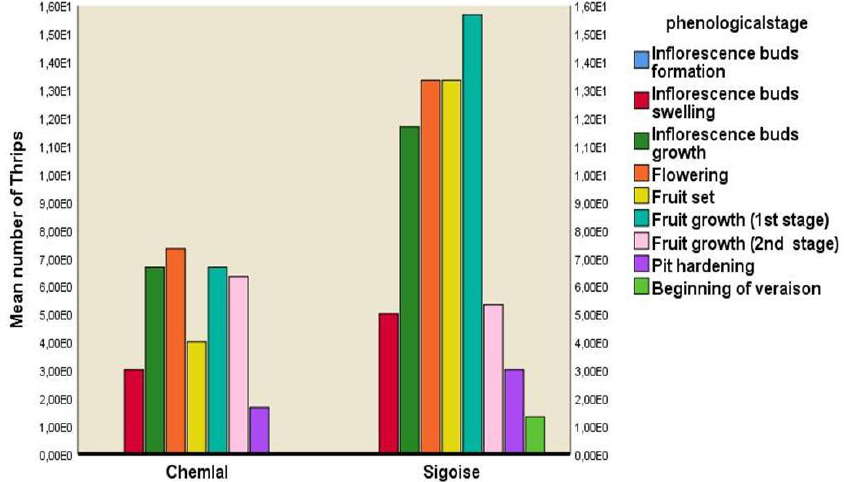
Figure 6. Mean number ofThrips adultsaccording to olive varieties phenological stages in Batna region.